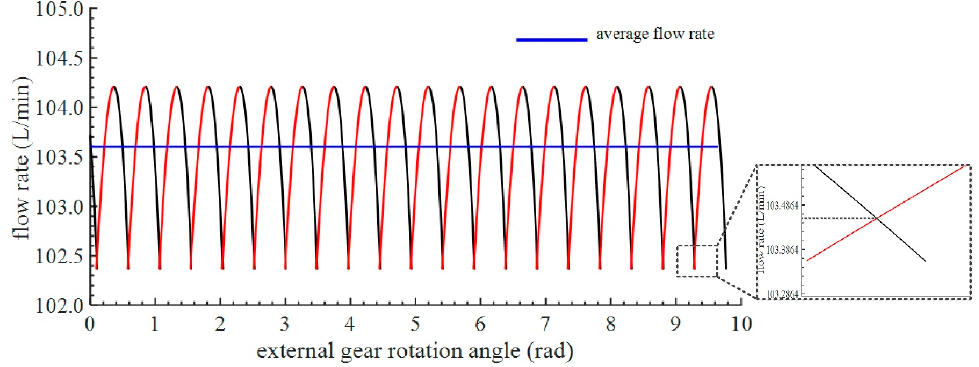
Figure 6. Theoretical flow rate curves corresponding to the actual coincidence degree.